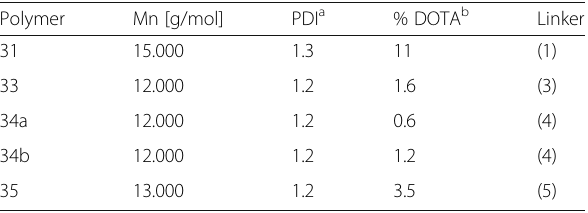
Table 2 Analytical data of the final HPMA-DOTA